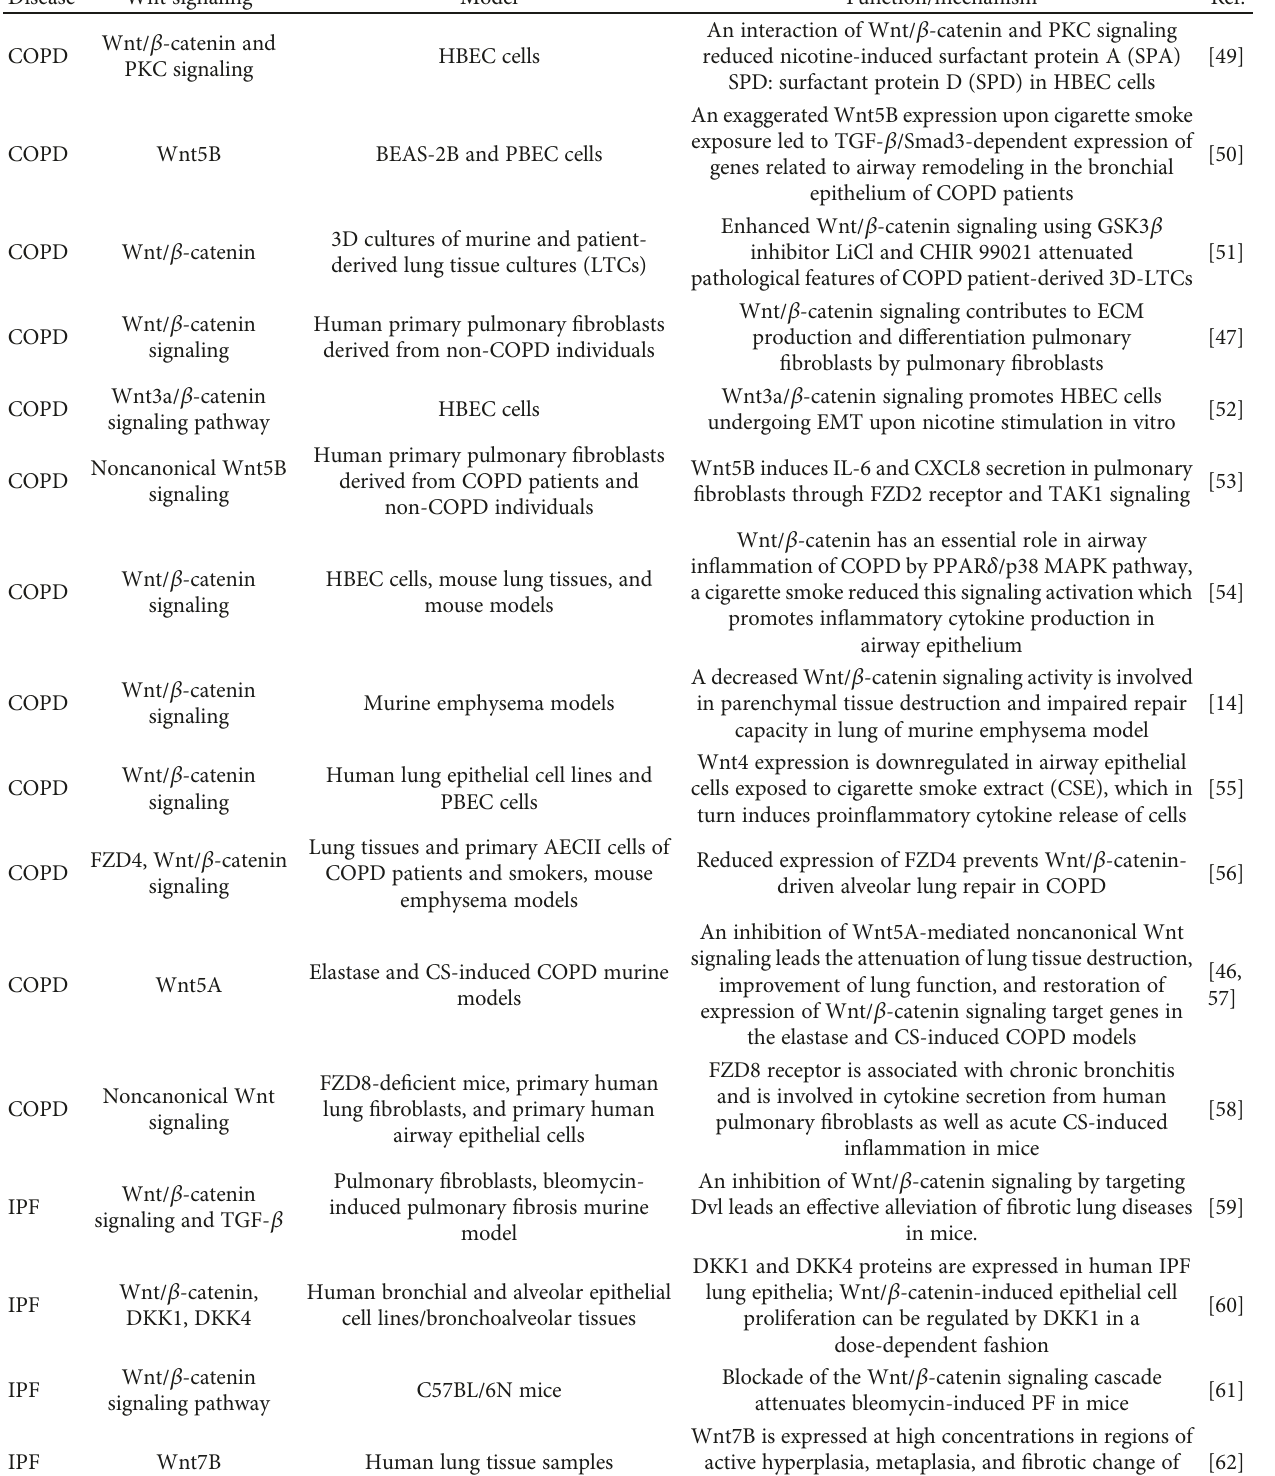
Table 1: Wnt signaling involved in the pathogenesis of COPD and